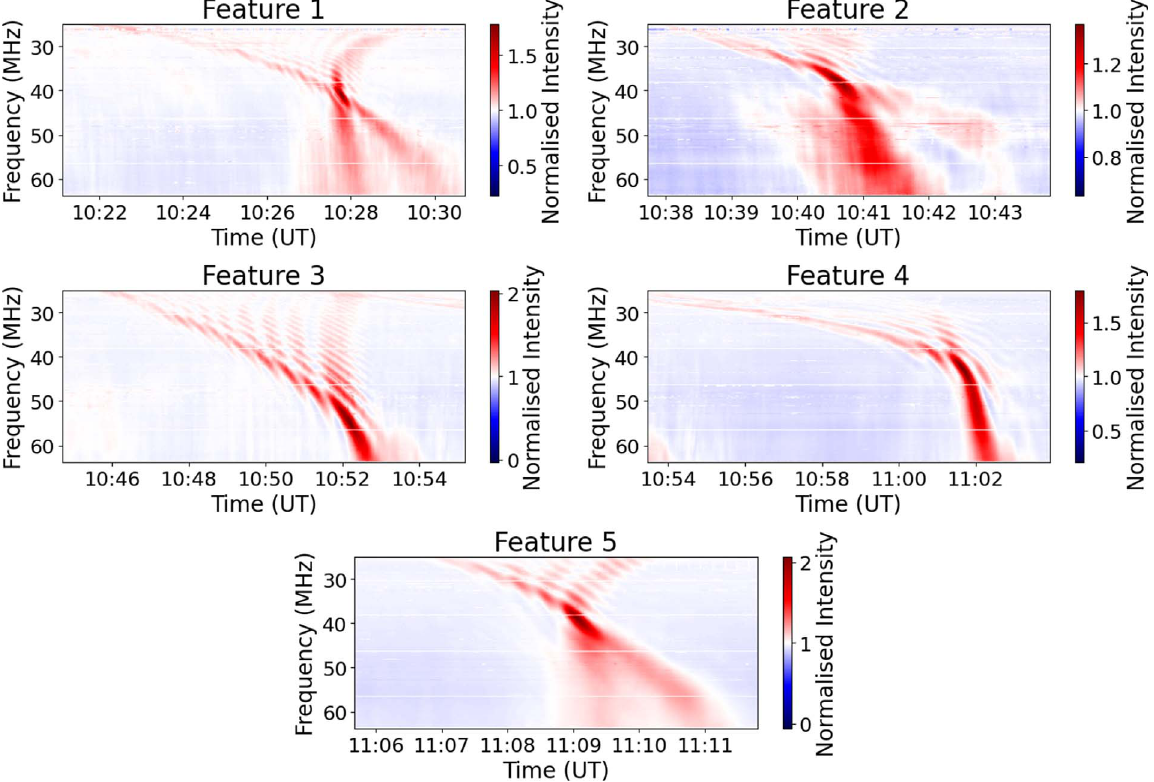
Fig. 2. The dynamic spectra of the fi ve features highlighted in Figure 1. Note that each panel uses a different colour scale for intensity to provide maximum contrast in each panel and that each has a different time